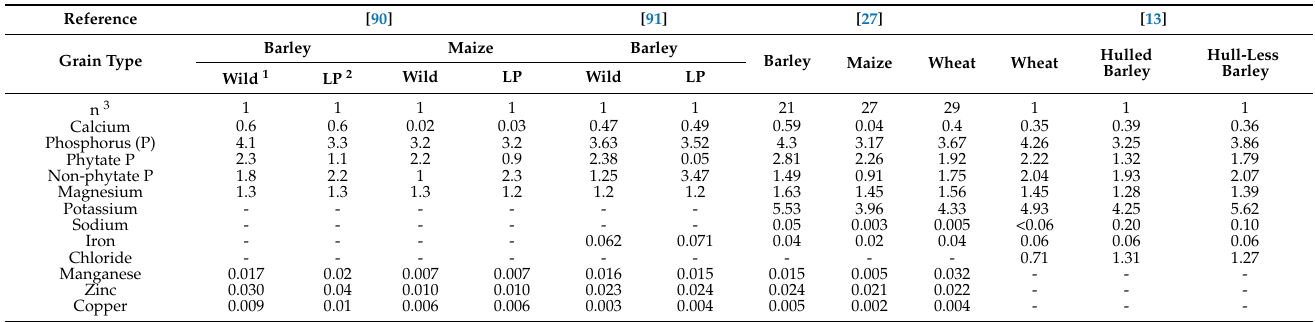
Table 4. Mineral composition of maize, barley and wheat grains (g/kg, DM